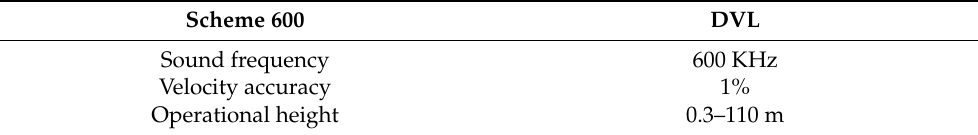
Table 2. Specification of DVL used on the AUV platform.